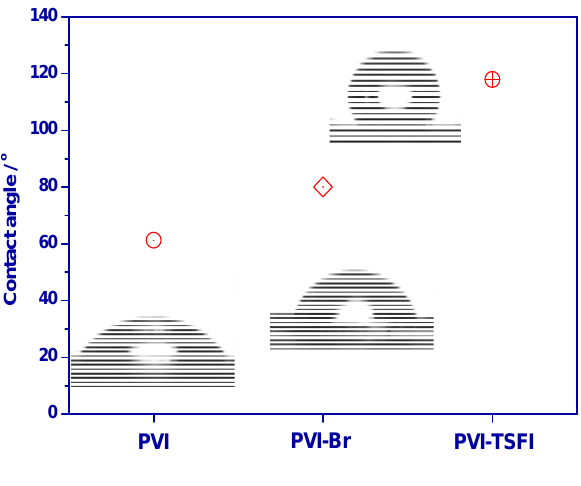
Figure 3. The static water contact angles and enclosed water droplet shapes of PVI, PVI-Br and PVI-TFSI.